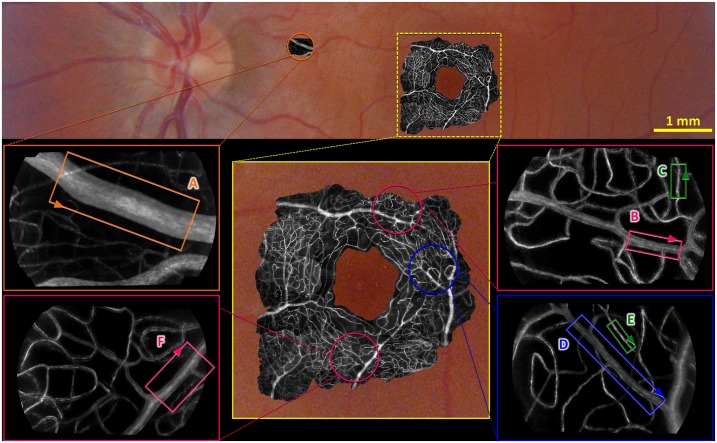
Standard retinal image (colour) of the inner retinal vasculature from one participant overlaid with motion contrast adaptive optics images (black and white) demonstrating the size and location of vessels analysed.Insets show examples of selected regions of interest. Within the insets, examples of vessel segments used for analysis have been indicated using rectangles labelled (A-F). Orange denotes a segment taken from a larger arteriole, pink from pre-capillary arterioles, green from capillaries and blue from a post-capillary venule. Arrowheads on the rectangles labelled A-F indicate the direction of flow and orientation of the corresponding segments A-F in subsequent figures.